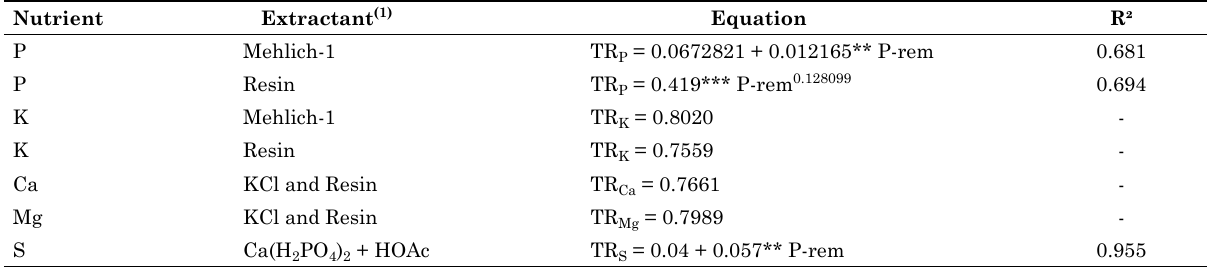
Table 2. Recovery efficiency of the nutrient from the soil by the extractant as a function, or not, of remaining phosphorus (p-rem)